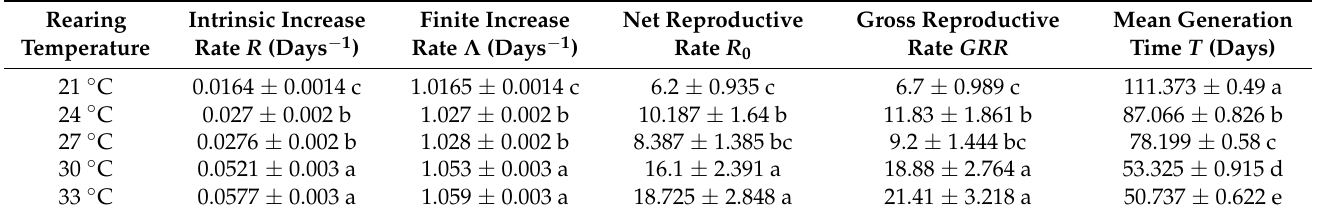
Figure 2. Age-specific survival rate ( l x ), age-specific fecundity ( m x ), and age-stage-specific reproductive value ( l x m x ) of L. serricorne at different temperatures. Table 2. Life table parameters of L. serricorne populations reared at different